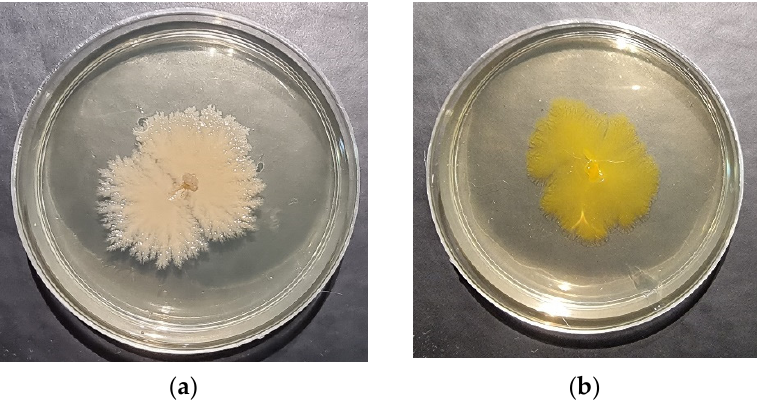
Figure 1. Morphology of bacterial species used in the experiments (on LB agar after 1 month incu- bation): ( a ) isolate PP— Paenibacillus sp.; ( b ) isolate L191B— Pseudomonas sp.